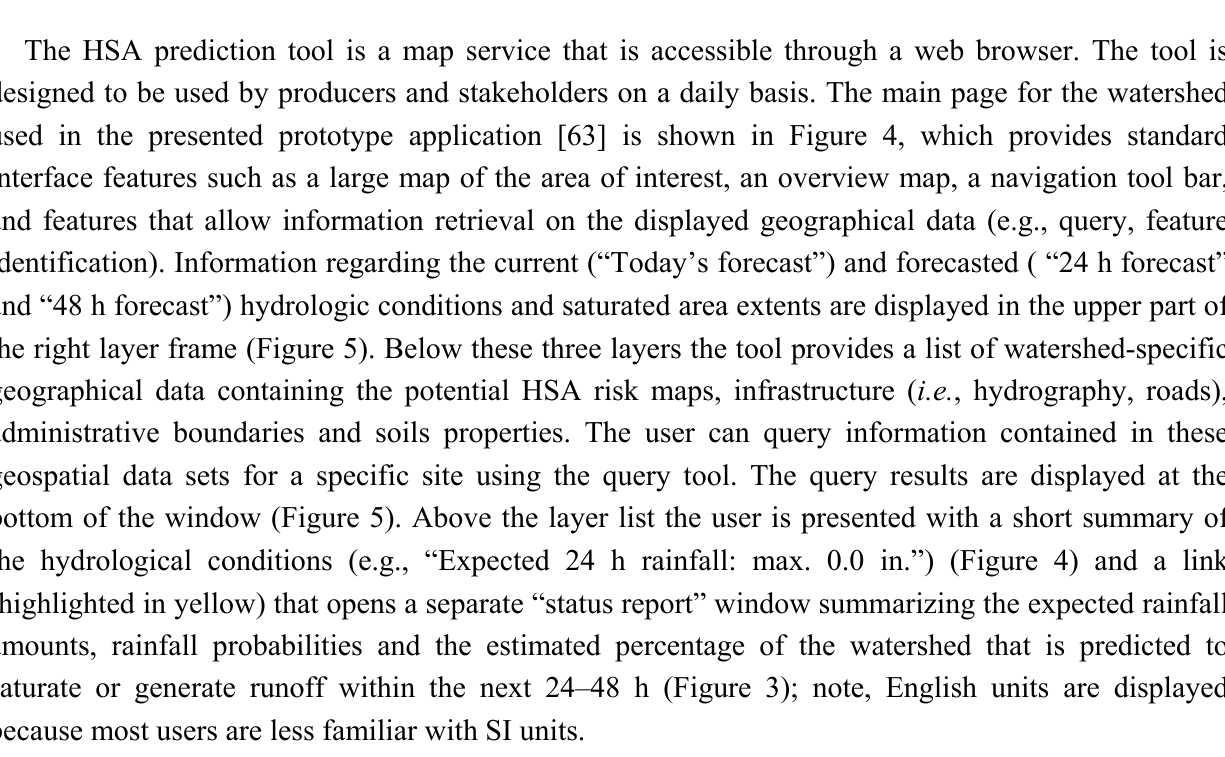
Figure 4. Start page and user interface of the HSA prediction